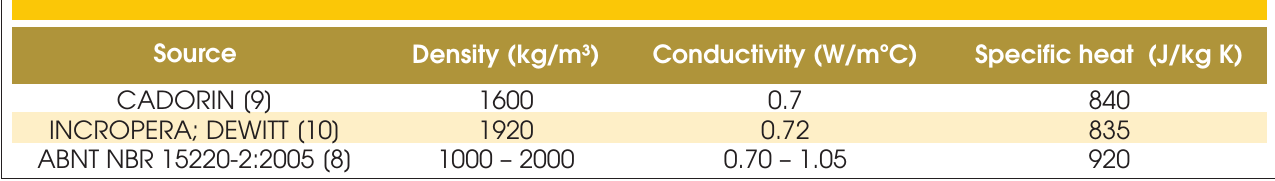
Table 1 – Properties of ceramic tiles at room temperature